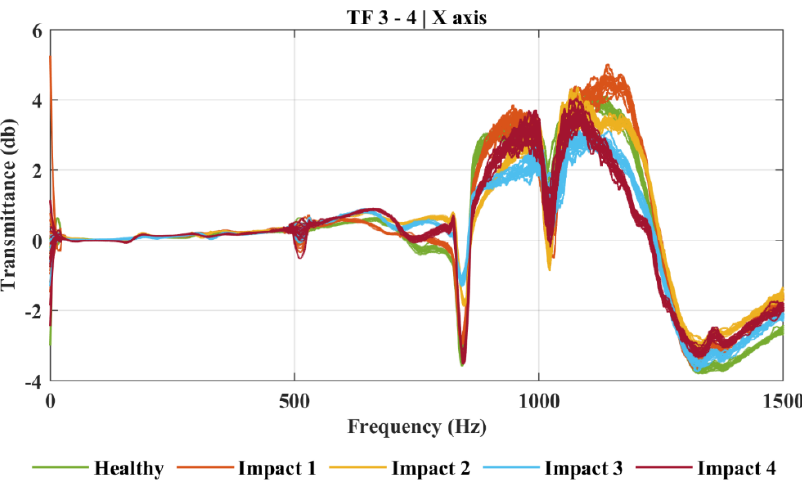
Figure 8. Transmittance functions (TF) on X-axis between accelerometer A3 and accelerometer A4.